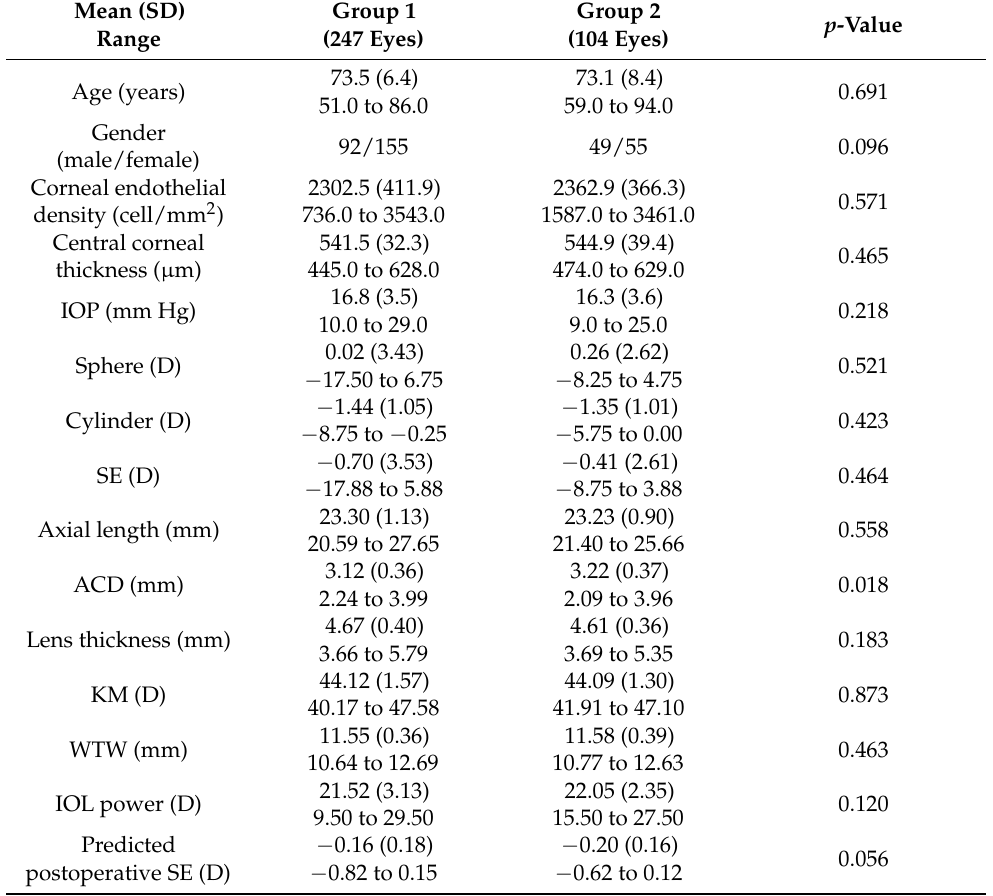
Table 1. Main preoperative characteristics in the two IOL groups of the current study: Group 1 (including 247 eyes implanted with the AcrySof SN60WF IQ IOL) and Group 2 (including 104 eyes implanted with the MI60L Akreos